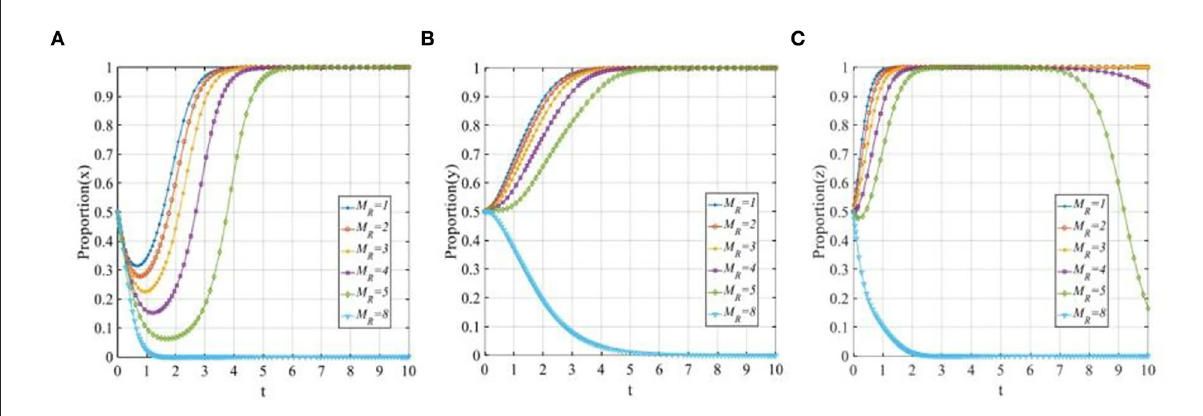
FIGURE15 The sensitivity analysis of the initial cost of financial regulators to set up the co-governance regulation pattern when M R = 1, 2, 3, 4, 5, 8. (A) The sensitivity of P2P lending platforms; (B) The sensitivity of investors; and (C) The sensitivity of financial